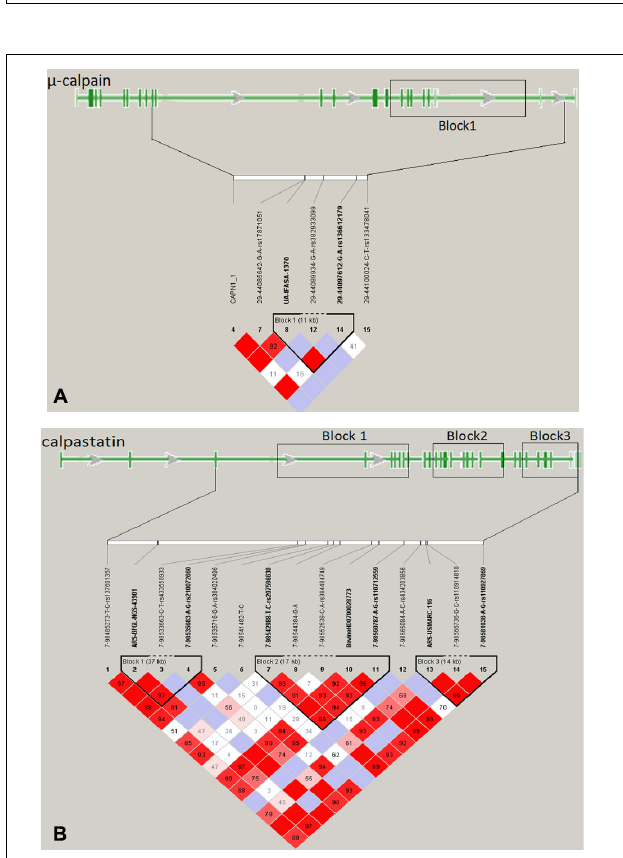
FIGURE 2 | Predicted linkage disequilibrium blocks for 569 steers from 196 families in an Angus-Brahman crossbred population. (A) µ -calpain gene; (B) calpastatin gene.